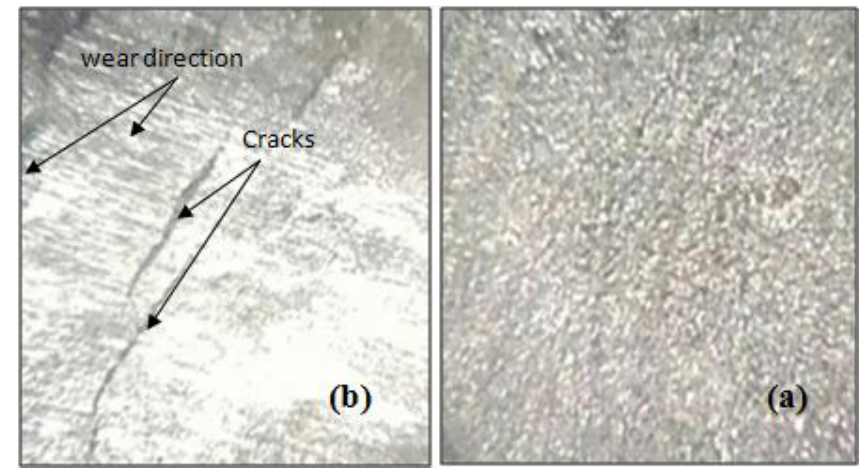
Fig. 9: The images of surface of sample (Ep + 4wt% of MWCNTs). (a) Before wear test. (b) After wear